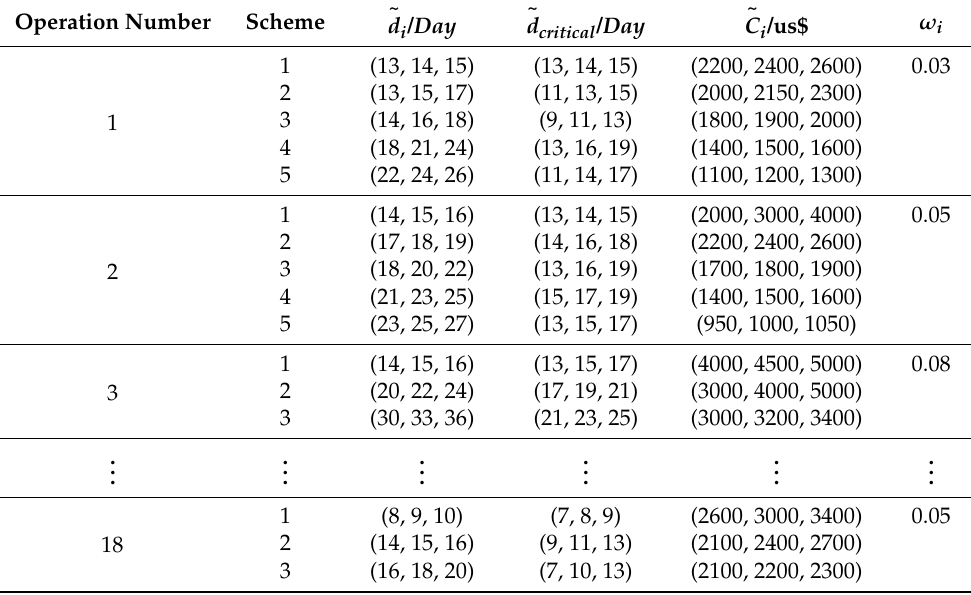
Figure 3. Network plan of the project. Table 2. Relevant parameters and data of each operation (for the example